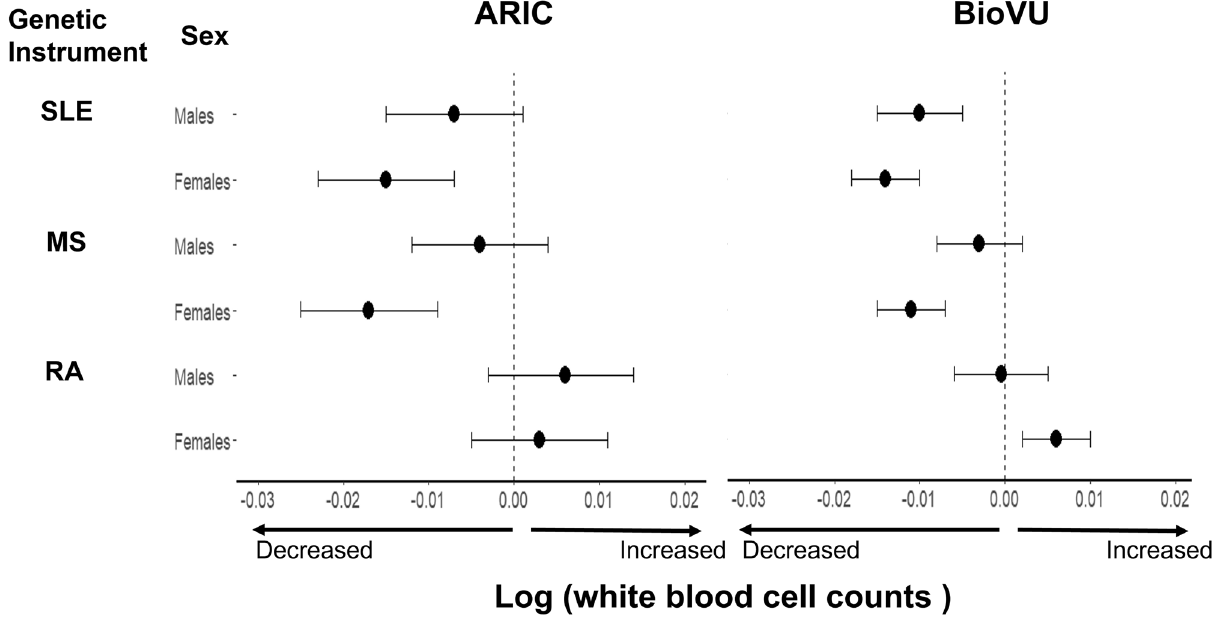
Figure 3. Association between polygenic risk scores for select autoimmune diseases and log transformed white blood cell counts, by sex, in ARIC and BioVU. Participants with a diagnosis of the respective autoimmune disease were excluded in BioVU. SLE systemic lupus erythematosus, MS multiple sclerosis, RA rheumatoid